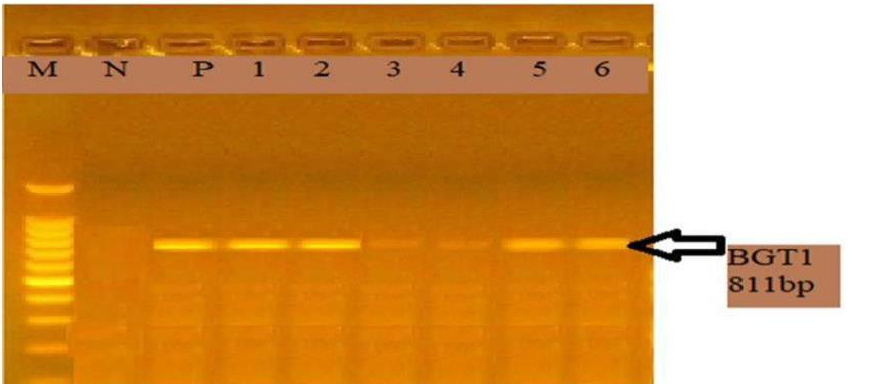
Fig. 7. Agarose gel electrophoresis of 811 bp specific PCR product for BGT1 gene for Aspergillus spp. using 1.5% agarose gel at 90V for 1hr. in 1x TBE buffer, and visualized under transilluminator UV after staining by ethidium bromide. Lane M: 100 bp. DNA ladder, lane (1, 2, 3, 4, 5, 6): positive result, lane N: negative control and lane P: positive